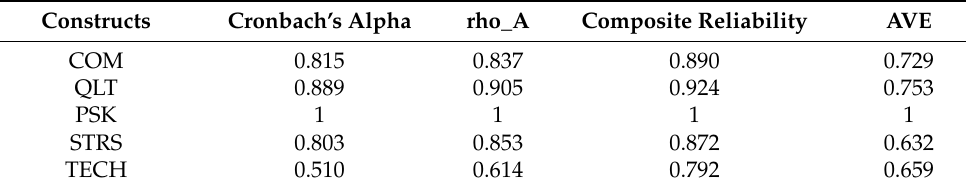
Table 4. The reliability and validity of the model